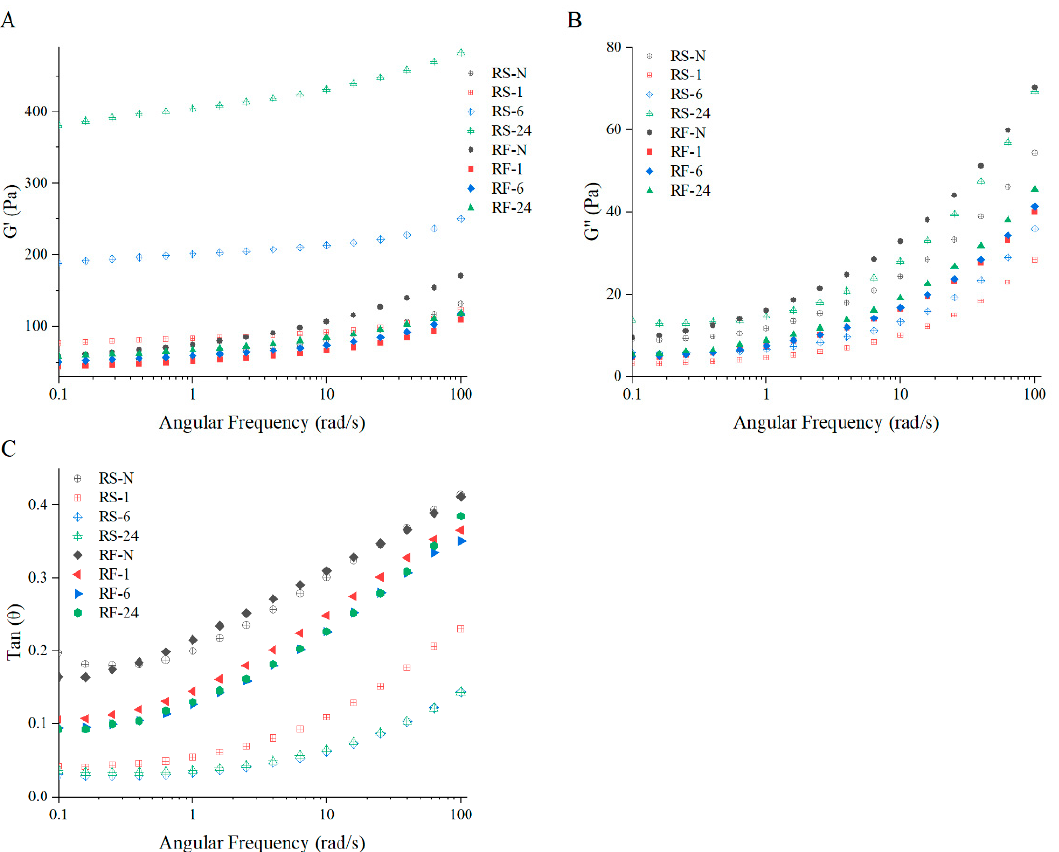
Figure 6. Viscoelastic characteristics of pastes formed by native and partially hydrolyzed RF and RS: variation of G’ ( A ) and G” ( B ) and Tan( θ ) ( C ) with angular frequency for samples. G’, storage modulus; G”, loss modulus, Tan ( θ ), loss factor. RF represents rice flour and RS represents rice starch; numbers refer to the hydrolysis time (hours); RF-N is native rice flour and RS-N is native starch isolated from rice flour.